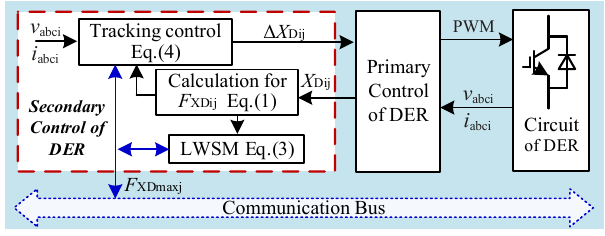
Figure 6. Control scheme of DER.